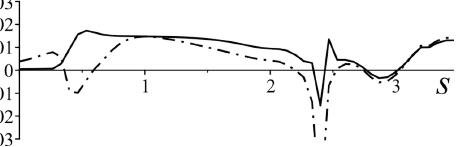
Figure 10. Conservation laws of energy (solid line) and y -flux (dashed line) at t = 0.64.